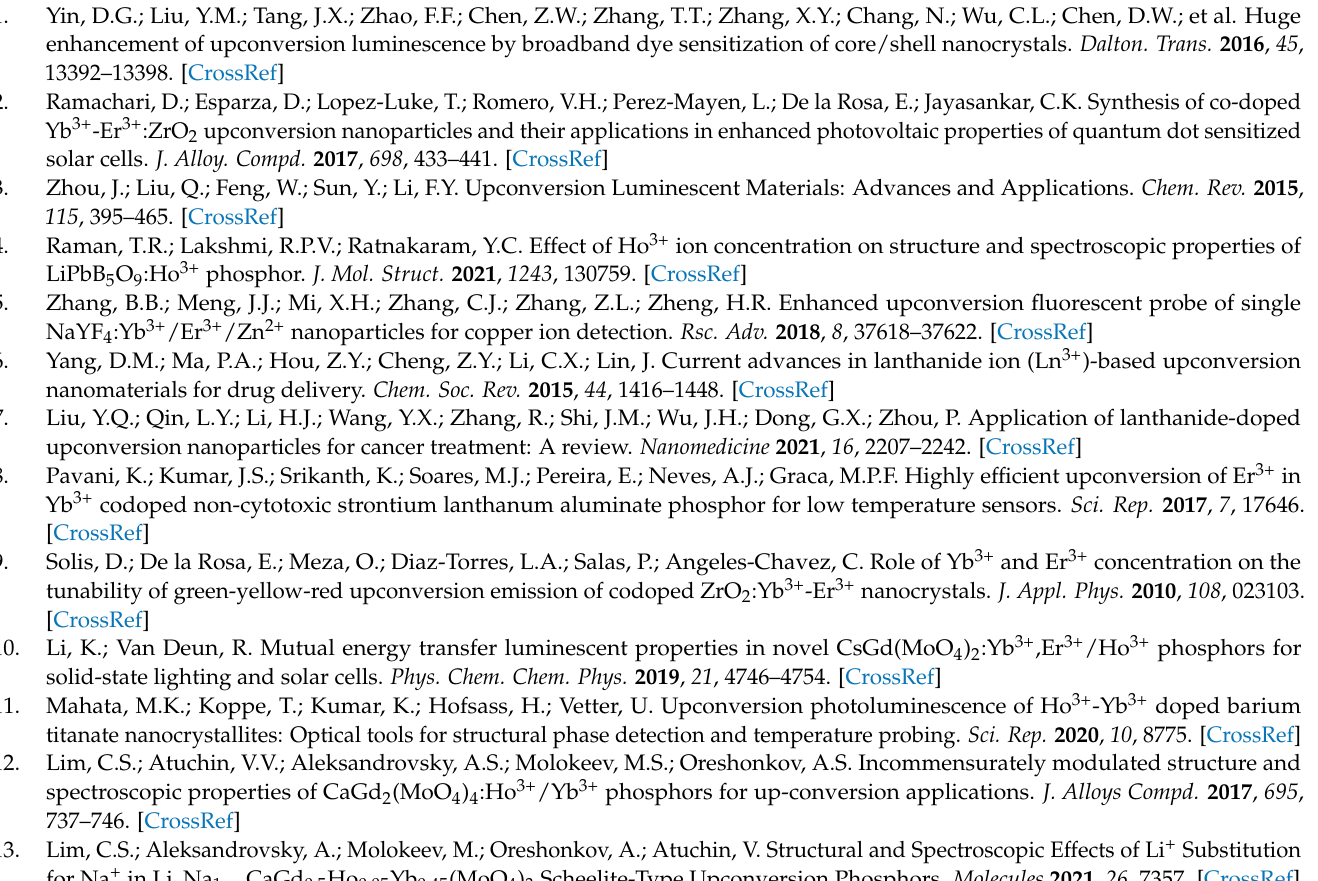
Figure S1. SEM images of K 2 Gd(PO 4 )(WO 4 ):20%Yb 3+ (a), K 2 Gd(PO 4 )(WO 4 ):10% Ho 3+ (b), and K 2 Gd(PO 4 )(WO 4 ):20%Yb 3+ ,10%Ho 3+ (c), Figure S2. Digital images of the K 2 Gd(PO 4 )(WO 4 ):20%Yb 3+